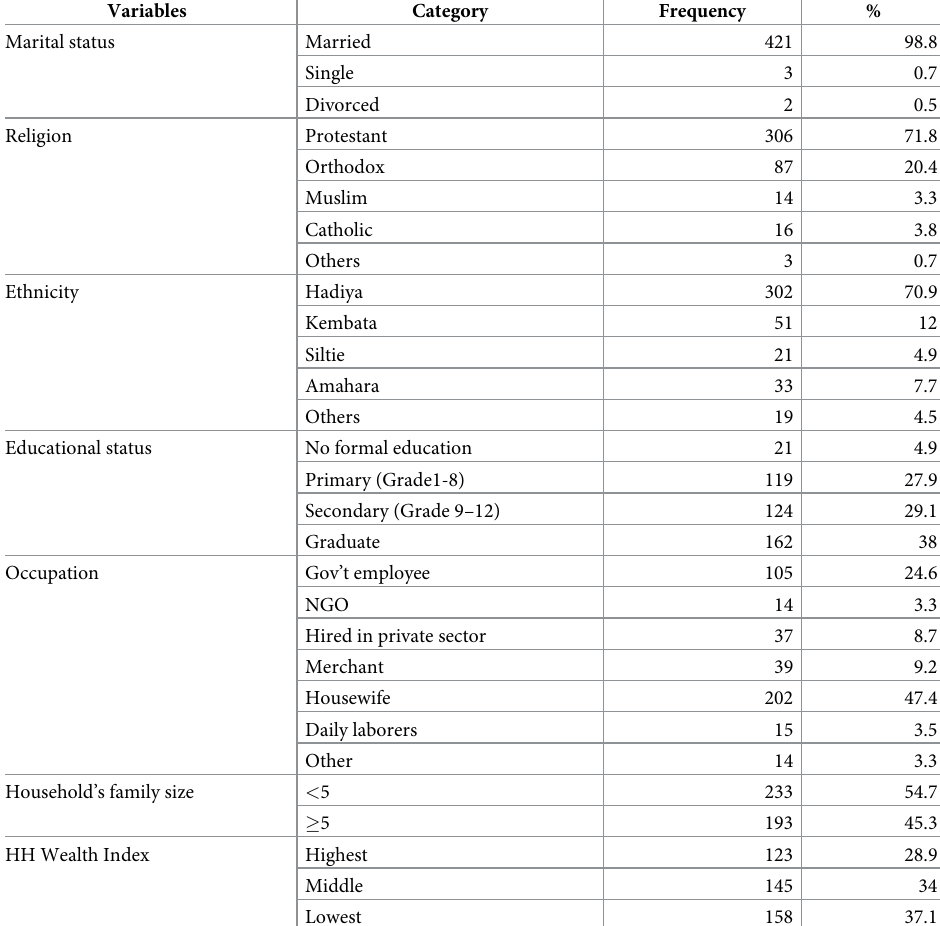
Table 1. Socio-demographic characteristics of pregnant women in Hosanna town, 2021 (n = 426).